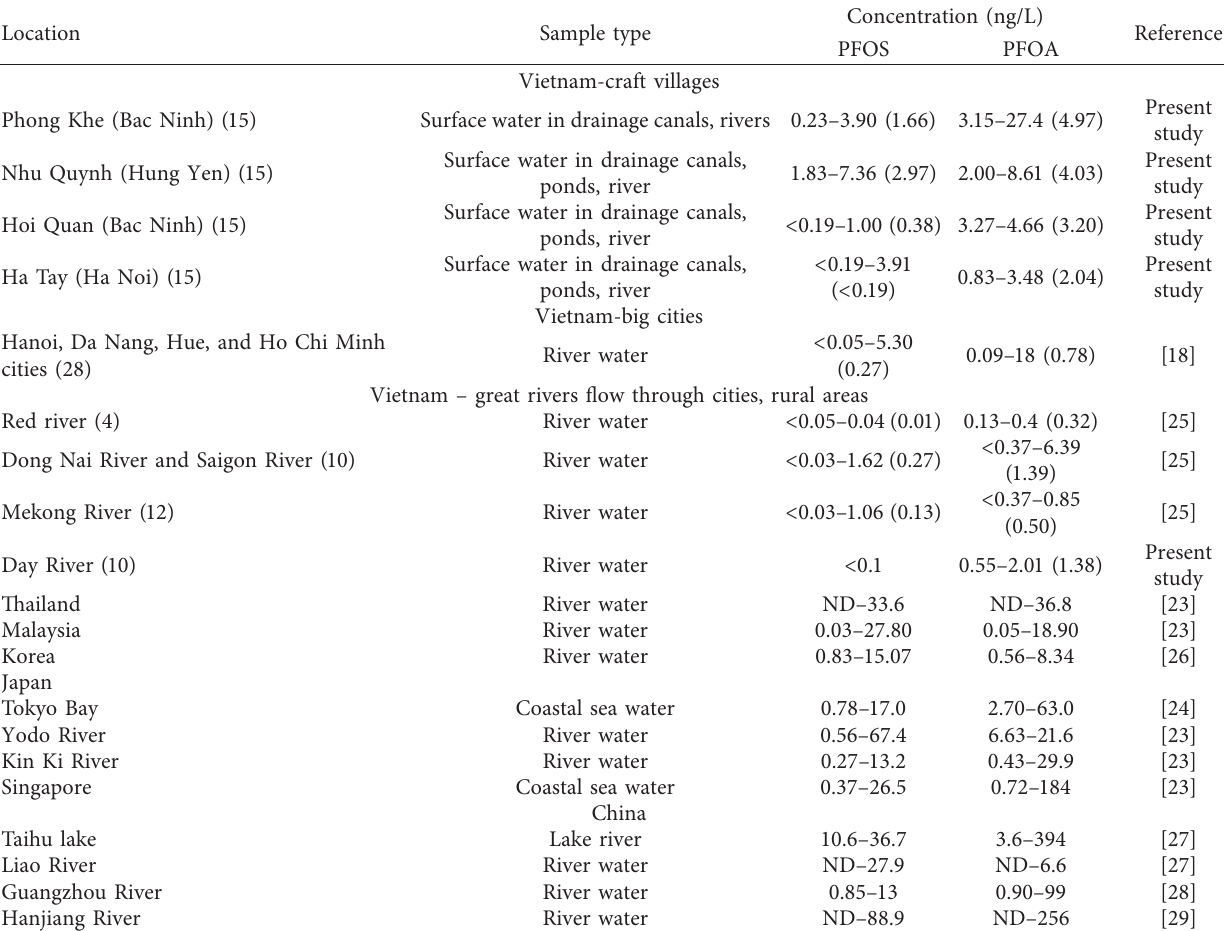
Table 4: Comparison between concentrations of PFOS and PFOA in surface water samples in Vietnam and other countries.